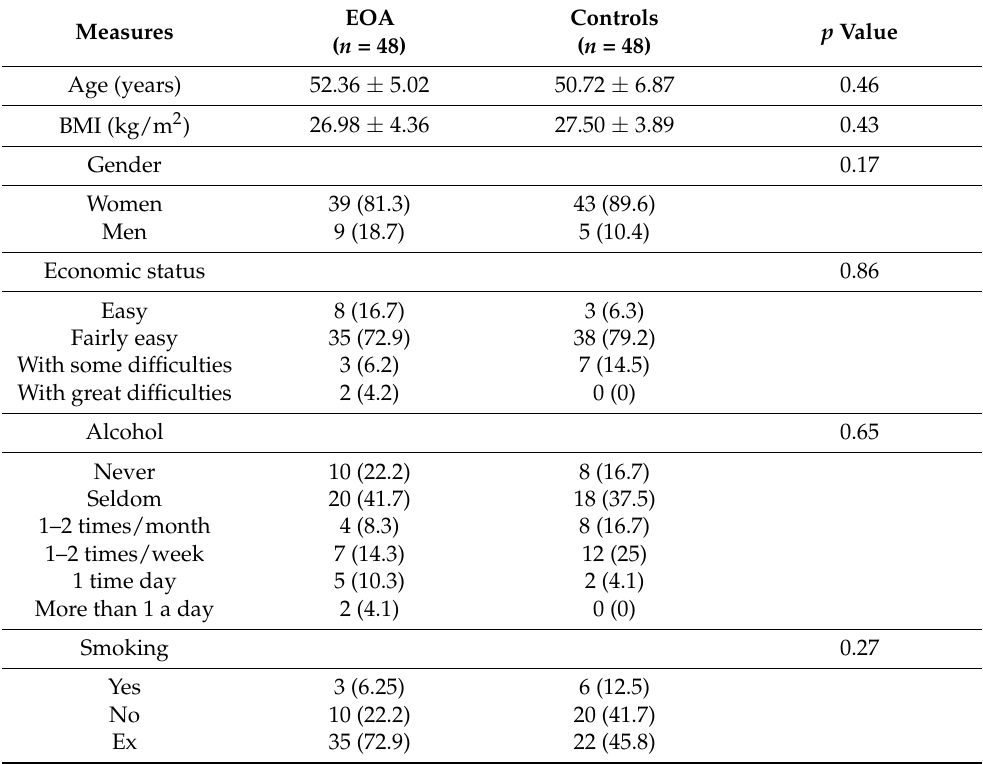
Table 1. Descriptive and demographic